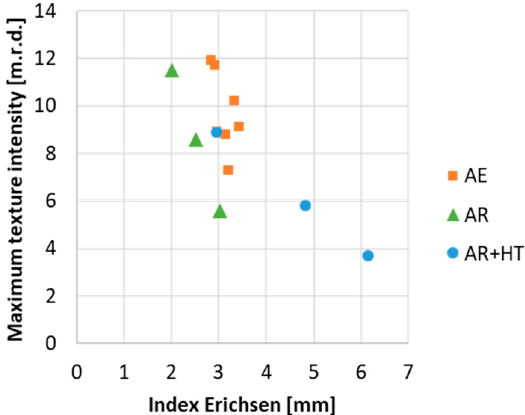
Figure 10. Correlation between texture (maximum intensity of the (0002) pole figure) and Erichsen value for the flat products produced at the different process temperatures: AE (as-extruded T E : 200– 500 °C), AR (as-rolled T R : 400–500 °C), HT (heat-treated 10 min at 450